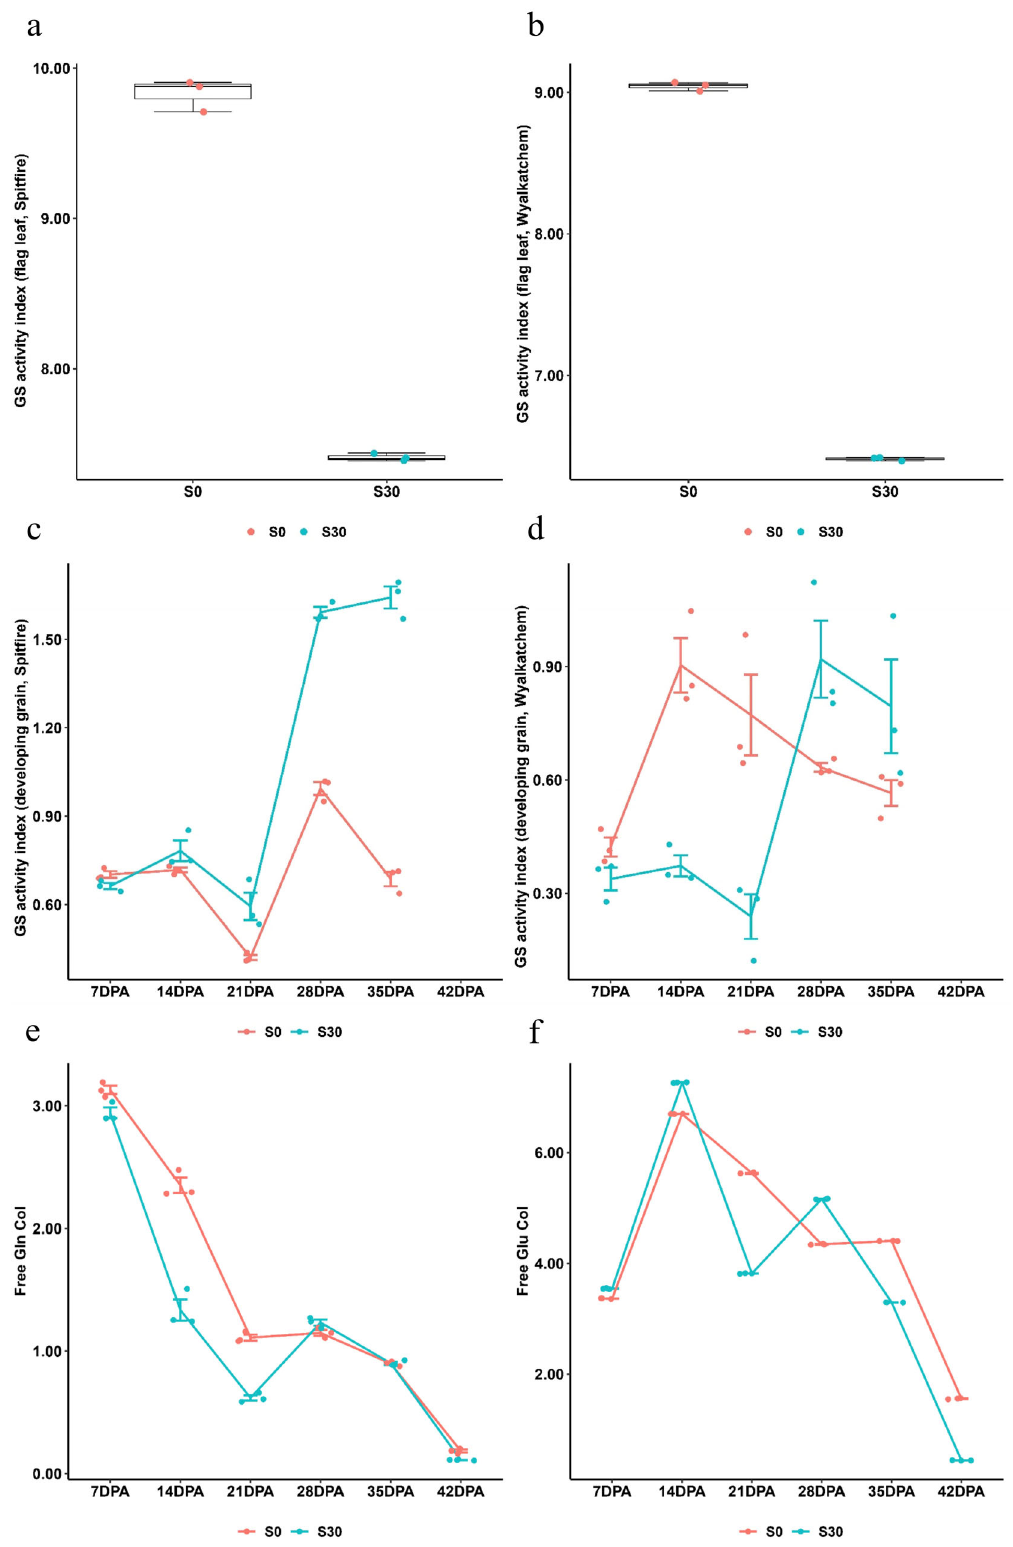
grain development until 14 DPA, followed by a subsequent downregulation until 21 DPA. At S0, the expression of MYB is downregulated but the expression of HMT-1 is upregulated from 7 to 14 DPA, followed by a reversed pattern from 14 to 21 DPA (Fig. 4). These expression patterns indicate that they may work synergistically as an activator at S30 and as a repressor at